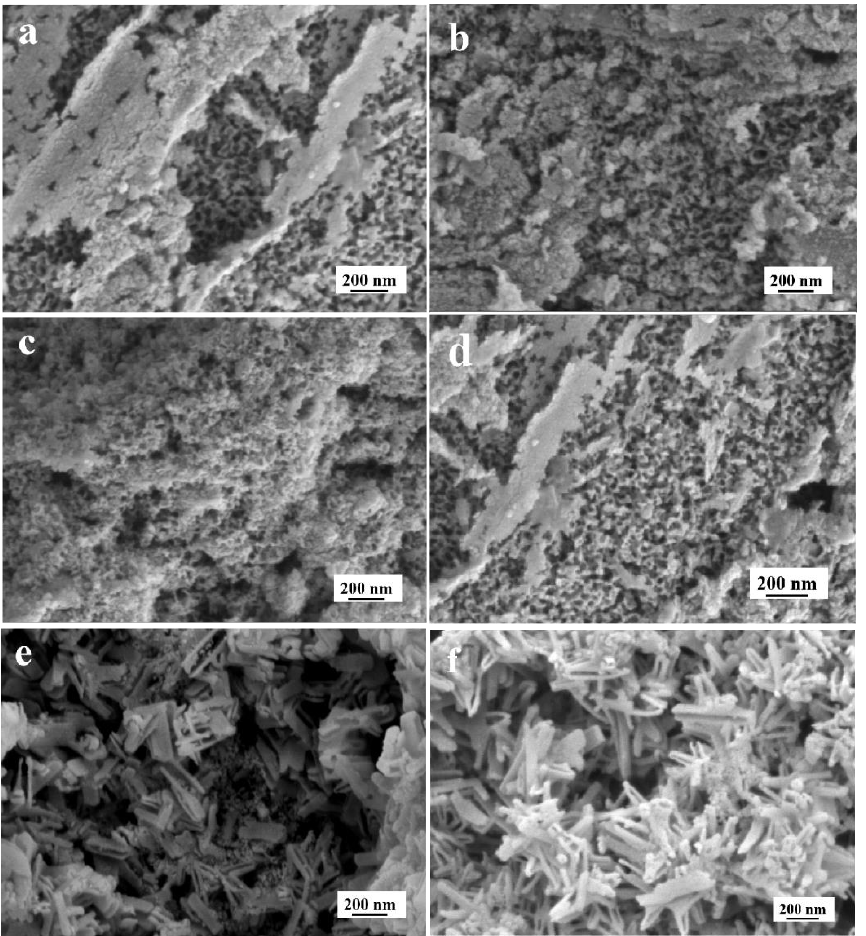
Figure 1. SEM images of Ti wires anodized in aqueous solution of NH 4 F. Anodic conditions: time, 30 min; voltage, 20 V; temperature, 25 °C. Concentration of NH 4 F ( ω %): 0.1% ( a ), 0.25% ( b ), 0.5% ( c ), 1.0% ( d ), 2.5% ( e ), 5.0% ( f ).